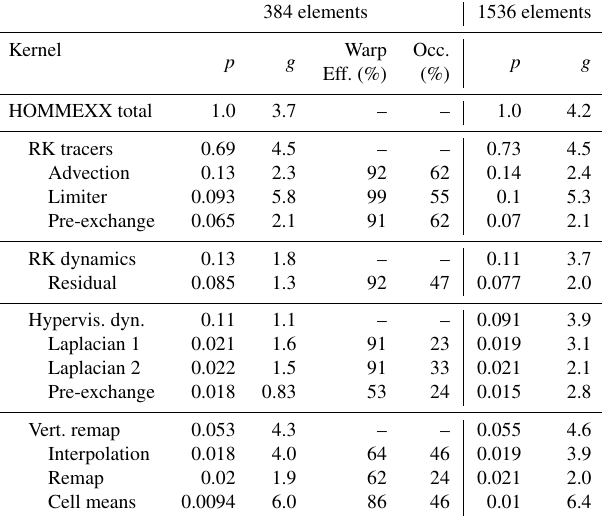
Table 2. V100 GPU performance